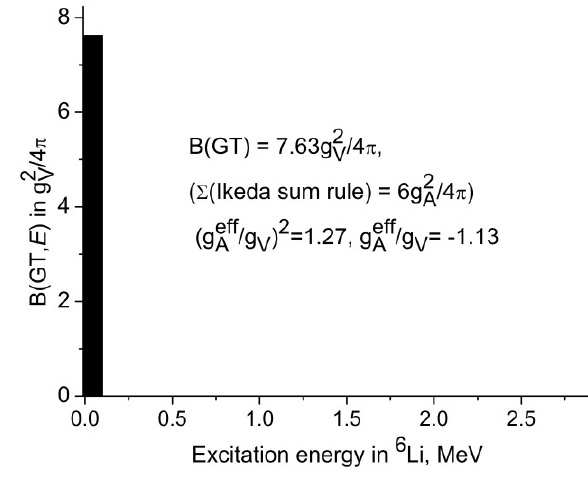
Fig. 2. Structure of the β-decay strength function for 6 He GT β - -decay in g V 2 /4π